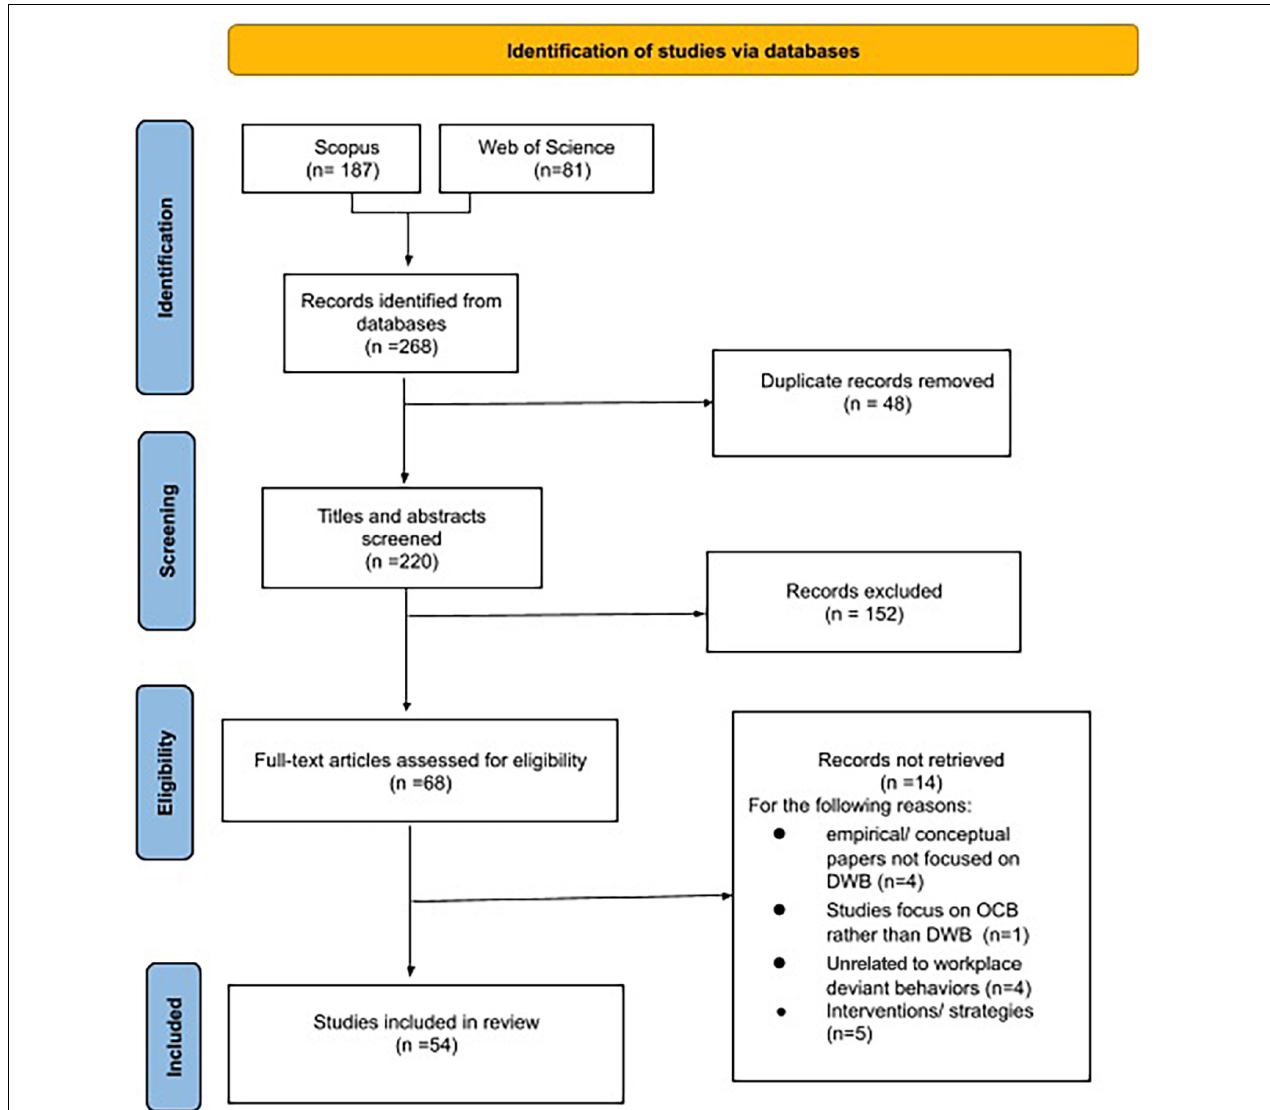
FIGURE 1 | PRISMA flow